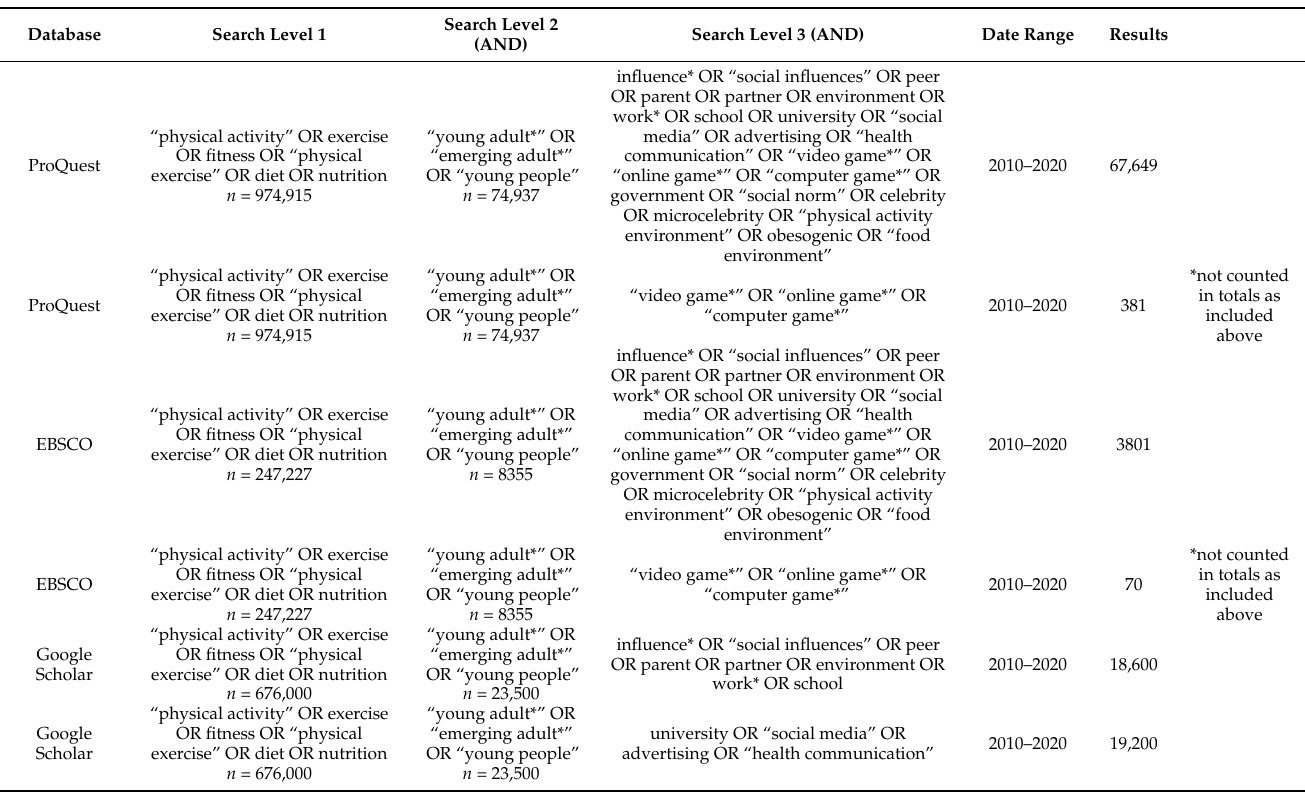
Table A2. Scoping review search terms and result